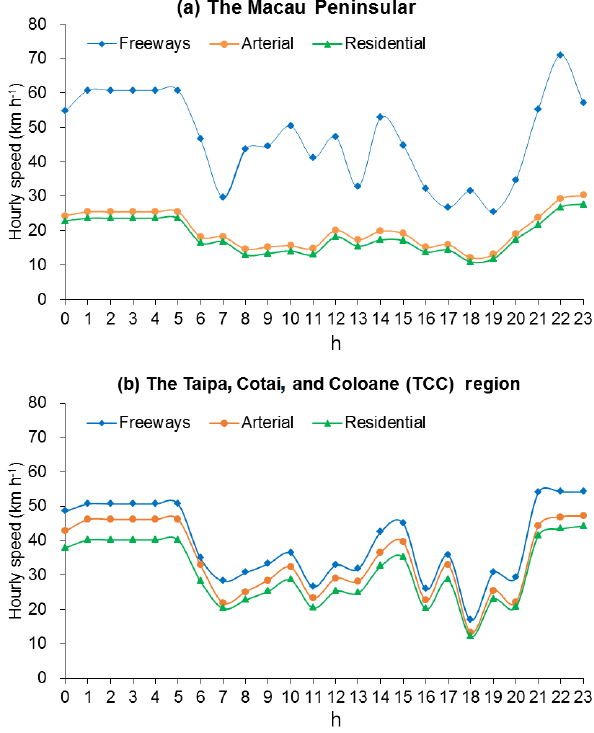
Figure 3. Variations in aggregated hourly speeds by road class and region for LDPVs during weekdays in